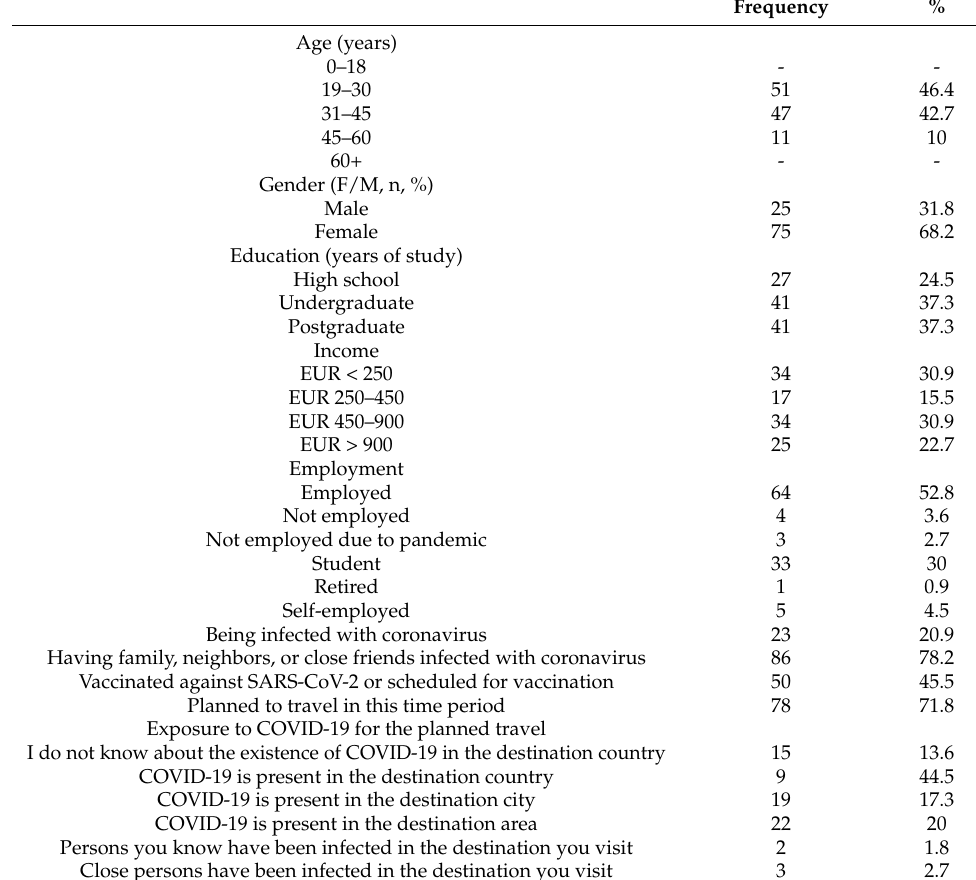
Table 1. Descriptive statistics for the demographic